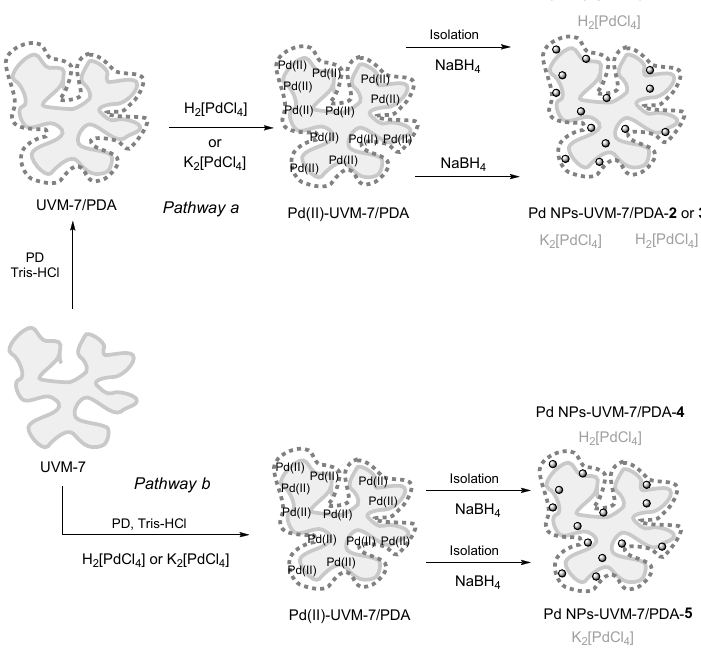
Figure 1. Synthesis scheme showing the two strategies or preparatory paths used: Pathway a (‘two-pot’ method) and Pathway b (‘one-pot’ method).